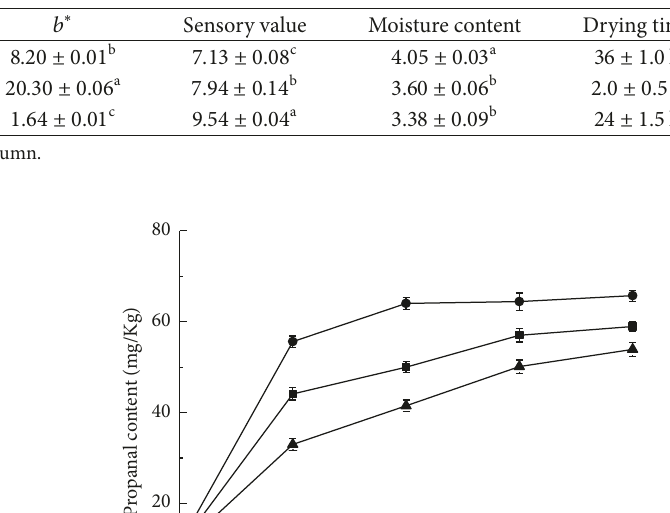
Table 1: Effect of different drying methods on color, sensory value, moisture content, and drying time of fish oil microcapsules.